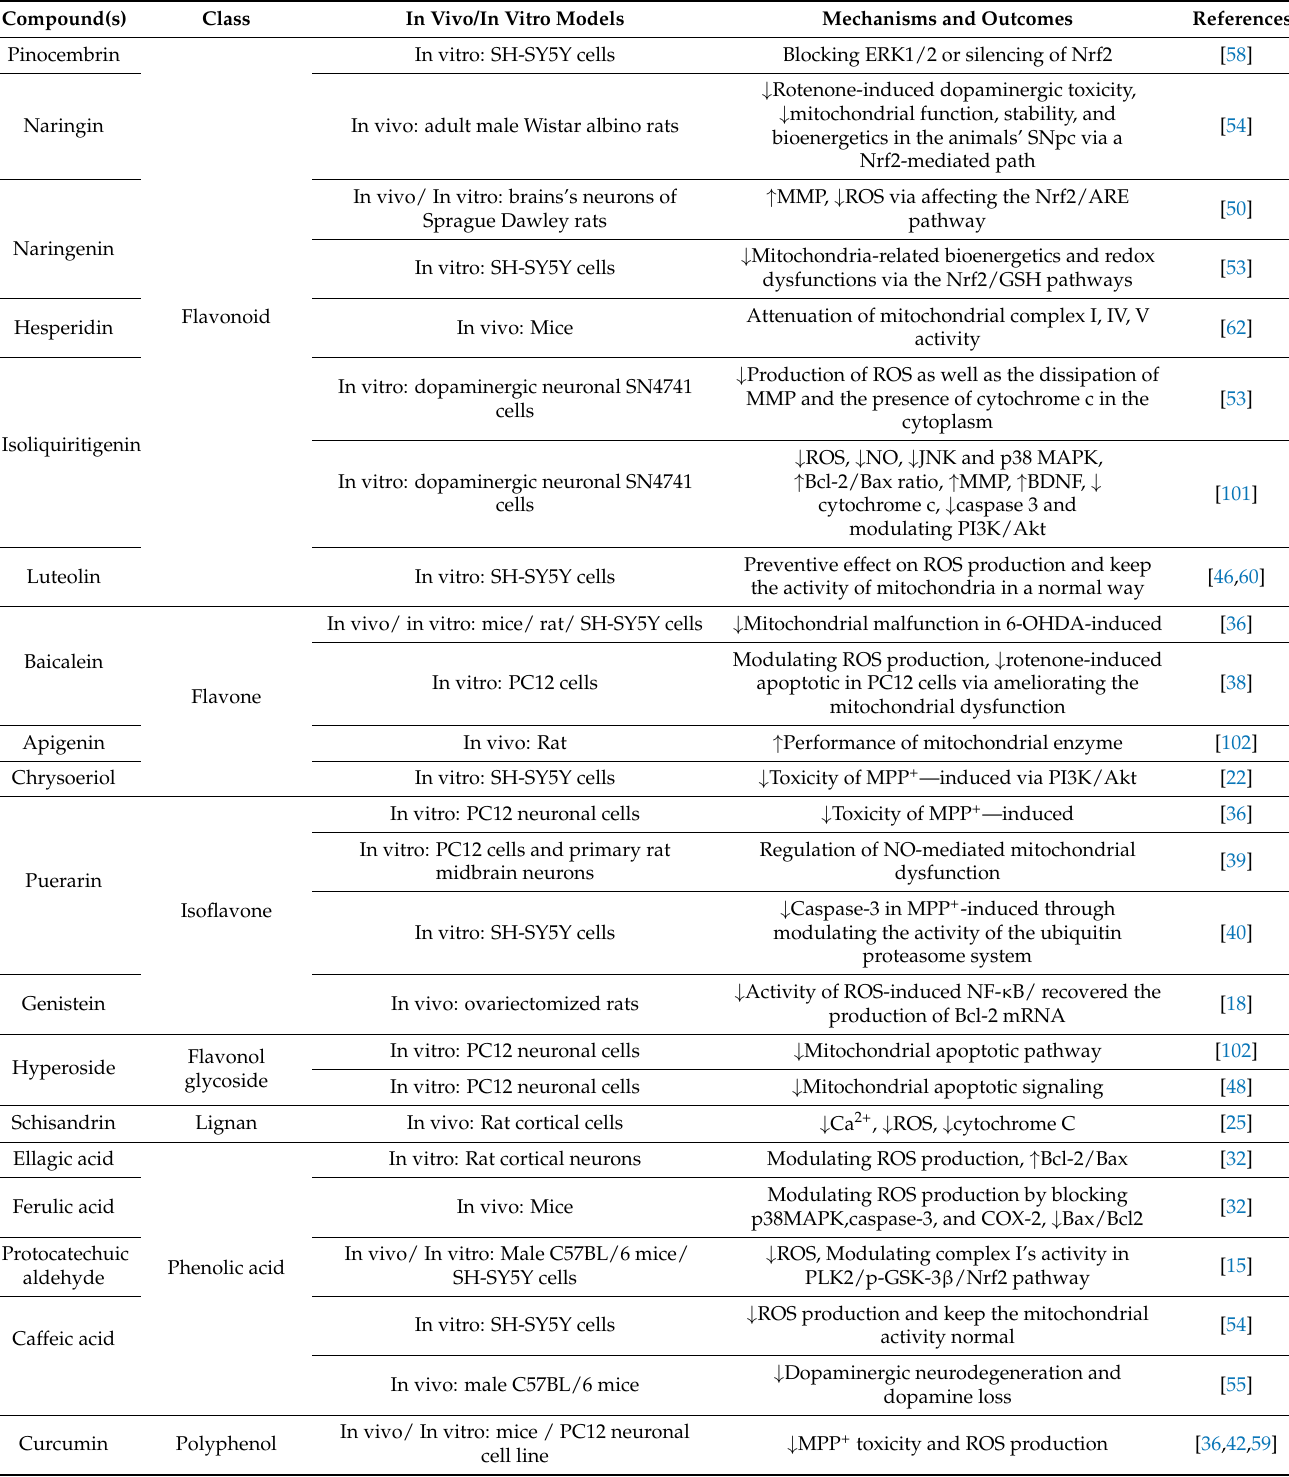
Table 1. Modulating mitochondria by plant secondary metabolites in